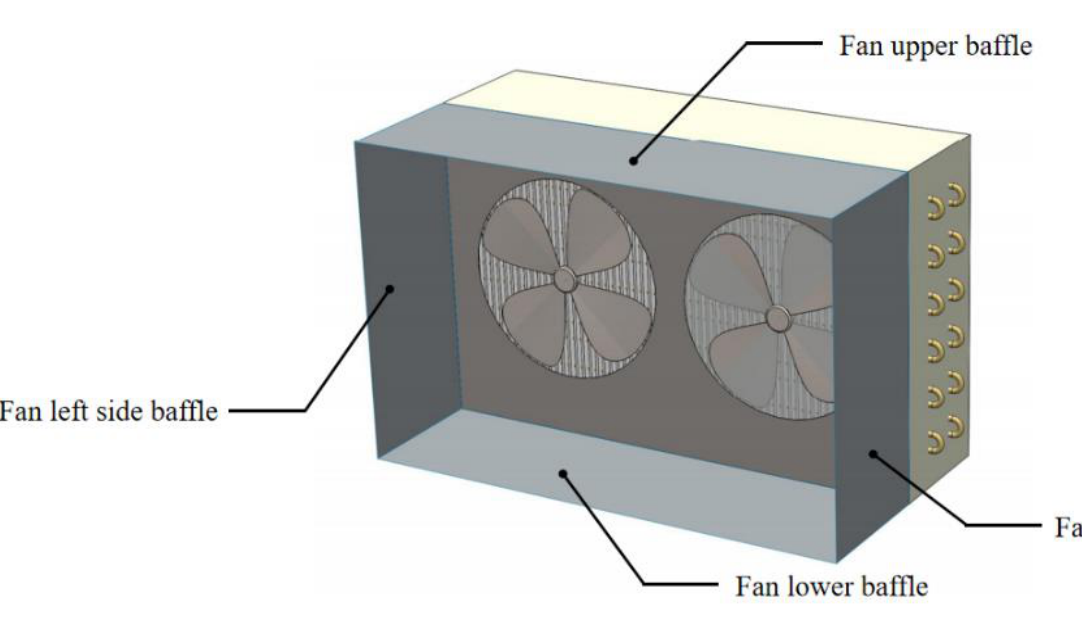
Figure 17. Arrangement diagram of FCU system with fan outlet baffle. Table 5. Summary of the coefficients of variation of horizontal velocity profile for different fan baffle